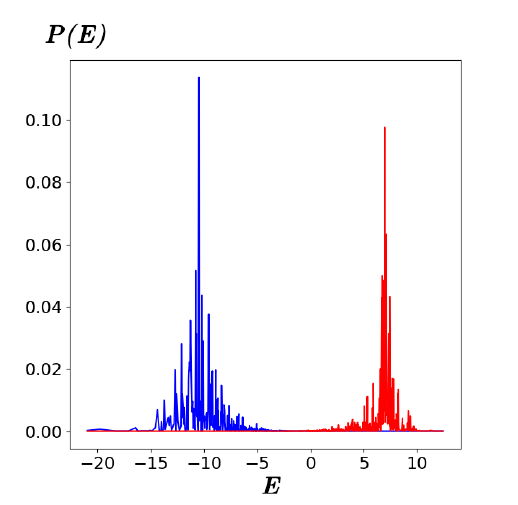
〉 (blue) and | Φ 〉 (red) in the eigenbasis of ˆ H 1 2